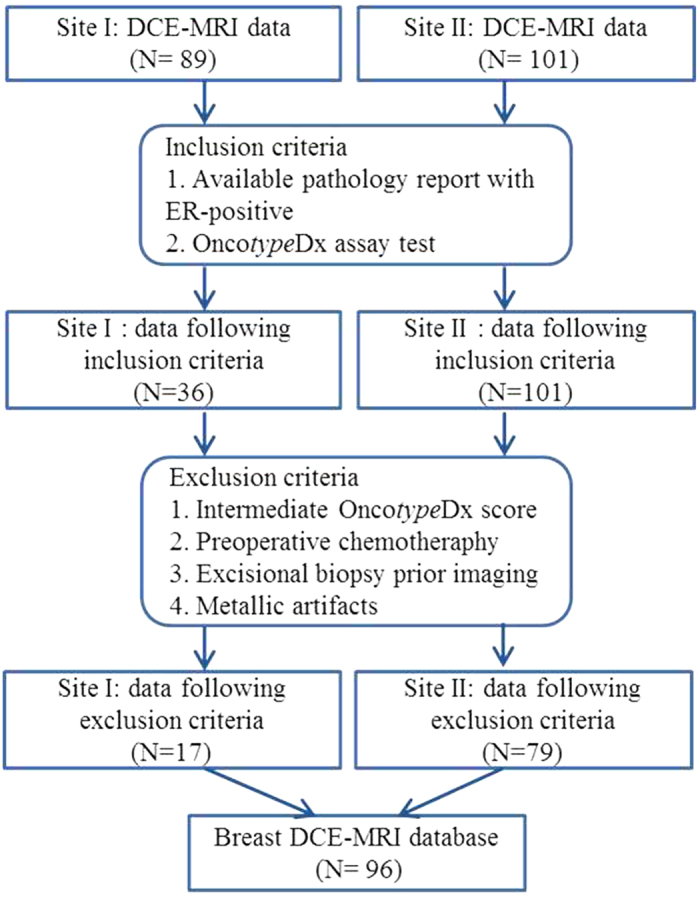
Flowchart of our study population with the patient inclusion and exclusion criteria.